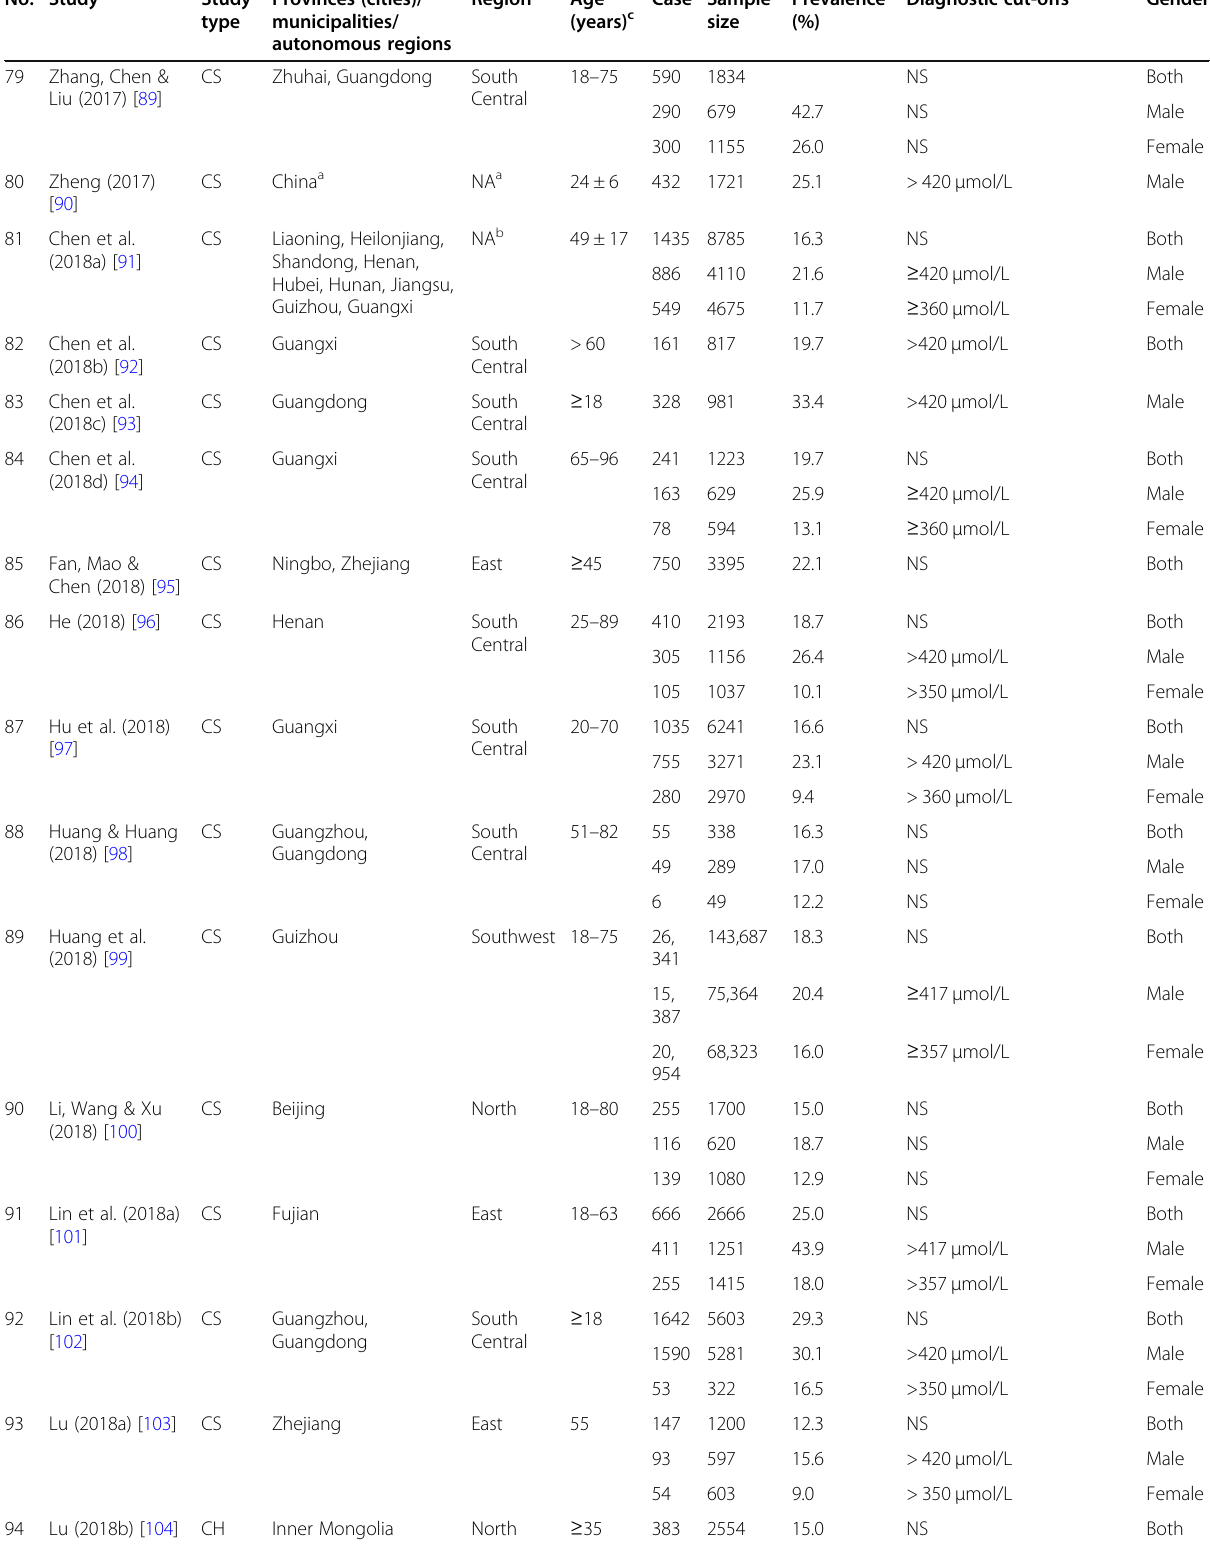
Table 1 Characteristics of the included studies in the systematic review and meta-analysis (Continued) No.